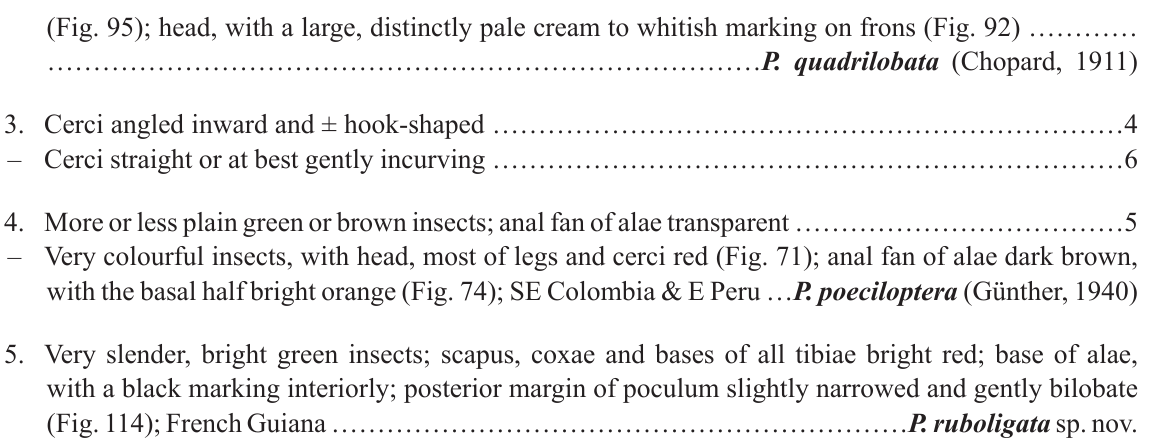
95); head, with a large, distinctly pale cream to whitish marking on frons (Fig. 92) ………… …………………………………………………………………… P. quadrilobata (Chopard, 1911) 3. Cerci angled inward and ± hook-shaped ……………………………………………………………4 – Cerci straight or at best gently incurving ……………………………………………………………6 4. More or less plain green or brown insects; anal fan of alae transparent ………………………………5 – Very colourful insects, with head, most of legs and cerci red (Fig. 71); anal fan of alae dark brown, with the basal half bright orange (Fig. 74); SE Colombia & E Peru … P. poeciloptera (Günther, 1940) 5. Very slender, bright green insects; scapus, coxae and bases of all tibiae bright red; base of alae, with a black marking interiorly; posterior margin of poculum slightly narrowed and gently bilobate (Fig. 114); French Guiana ……………………………………………………… P. ruboligata sp. nov. – Stocky, dull greenish brown; abominal sternites II–V black; base of alae, without a dark marking; posterior margin of poculum widened, obtusely angular and preceded by a conspicuous narrowing (Fig. 44); E Peru ………………………………………………… P. heteronemia (Günther, 1940) 6. Head ± unicoloured,, without conspicuous dark markings …………………………………………7 – Head, with distinct and well defined dark markings or lines ………………………………………9 7. Very delicate insects; head indistinctly wider than prothorax ………………………………………8 – Comparatively stocky; head globose and almost 2× as wide as prothorax (Fig. 8) … P. adiposa sp. nov. 8. All longitudinal veins of tegmina and alae marked, with brown (Fig. 120) ……………………… ………………………………………………………………………… P. valgius (Westwood, 1859) – Tegmina and costal region of alae plain green (Fig. 78) ………… P. puppeia (Westwood, 1859) 9. Head, with a single bold central black marking or longitudinal stripe ………………………………10 – Head, with various dark markings …………………………………………………………………11 10. Colourful insects, green, with bases of tibiae red and apices of femora and tibiae black; costal region of alae, with a dark brown longitudinal stripe interiorly (Fig. 15); posterior margin of anal segment bilobate, with a deep and narrow median incision; E Ecuador ……… P. amabile sp. nov. – Greenish brown insects; no dark longitudinal stripe on costal region of alae; posterior margin of anal segment only, with a very slight median indentation (Fig. 59); French Guiana … P. nigrolineata sp. nov. 11. Anal segment ± cucullate; cerci short and projecting beyond apex of abdomen by no more than half the length of the anal segment ……………………………………………………………………12 – Anal segment flattened and almost parallel-sided, the posterior margin, with a wide triangular excavation (Fig. 30); cerci very long and projecting beyond apex of abdomen by almost the length of the anal segment; French Guiana ………………………………………… P. guianensis sp. nov. 12. Head elongate, cheeks parallel-sided and with two fine dark longitudinal postocular stripes (Fig. 21); pronotum, with a fine longitudinal black line along lateral margins; poculum, with lateral margins roundly emarginated and apical half strongly narrowed (Fig. 24); French Guiana ……… ………………….........................……………………………………………… P. femorata sp. nov. – Head ovoid, vertex, with two bold diverging dorsal stripes (Fig. 47); pronotum, without a dark lateral line; poculum cup-shaped, with lateral margins straight and posterior portion not conspicuously narrowed; East Peru …………………………………………… P. montana (Redtenbacher,